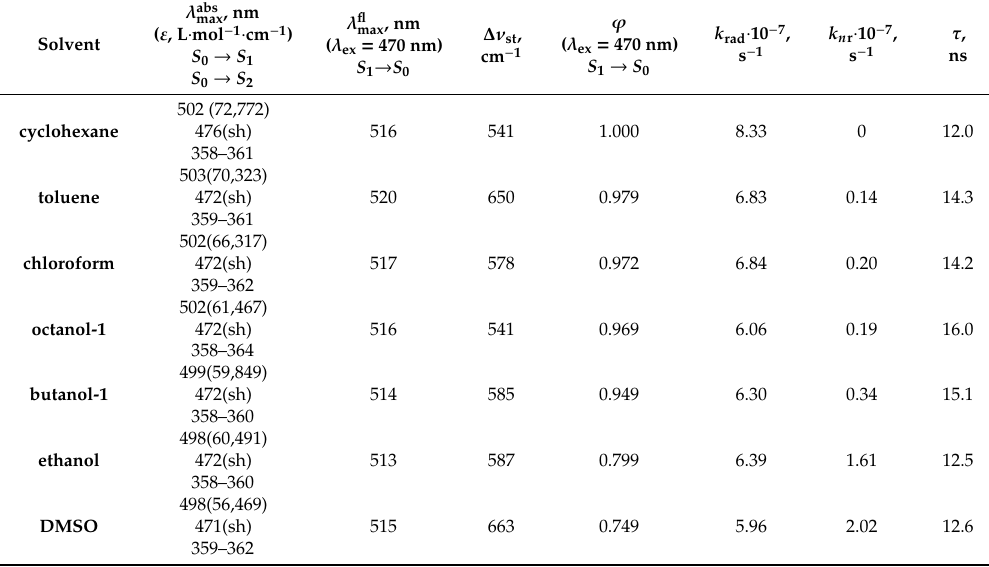
Table 1. The spectroscopic characteristics of [BF 2 L] in organic solvents 1